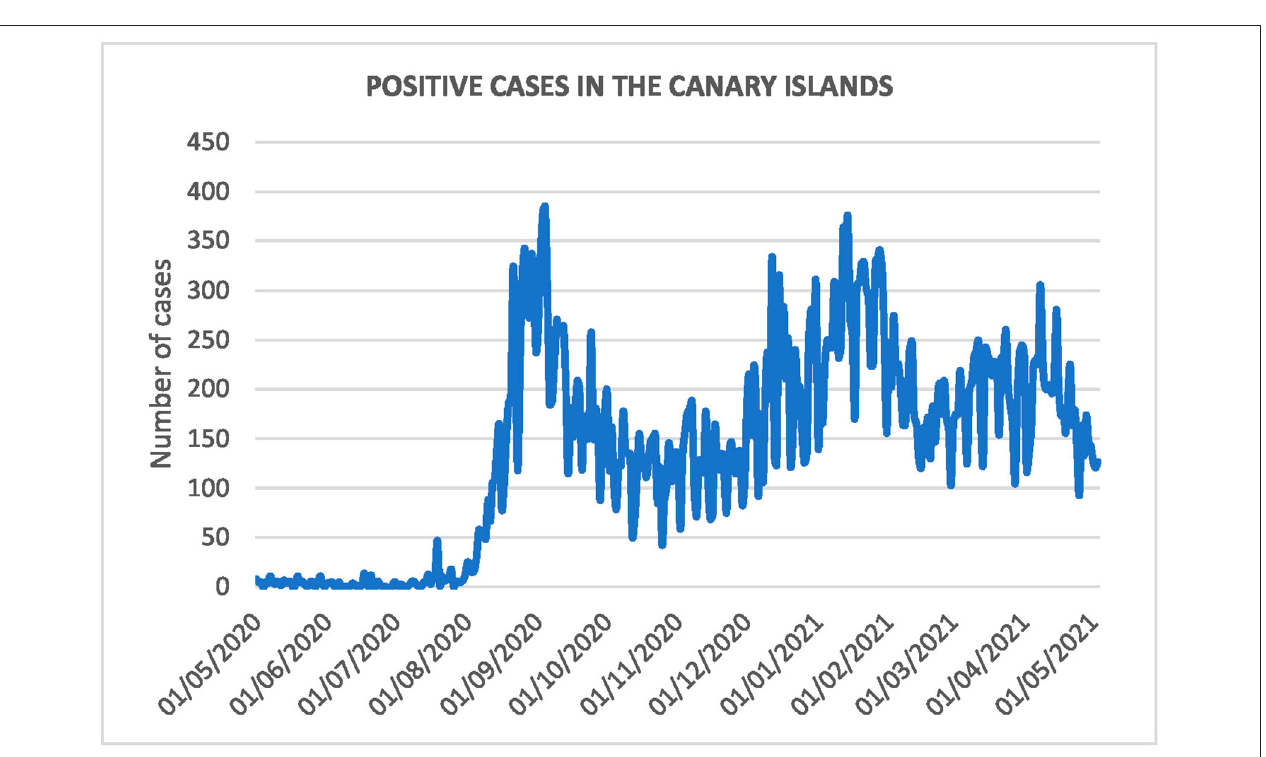
FIGURE 5 | Number of positive cases during the